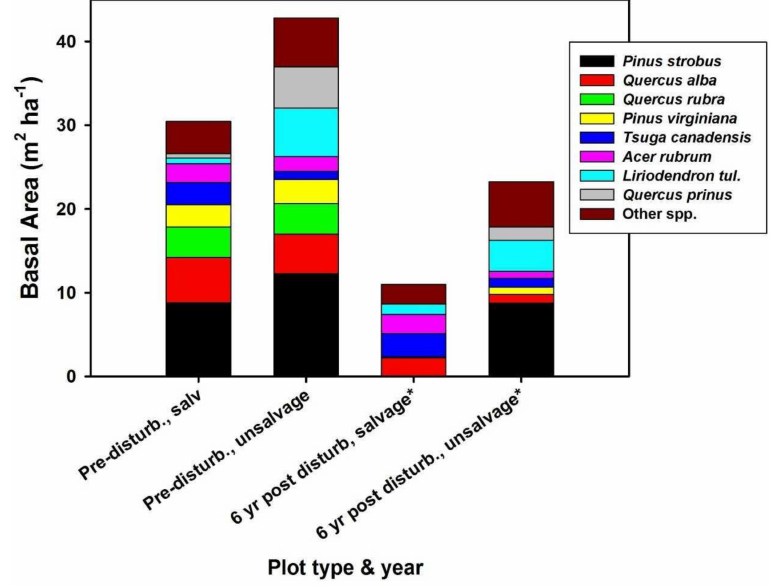
Figure 7. Stacked bars show the basal area (m 2 ha − 1 ) per species per disturbance condition: pre-tornado pre-salvage, pre-tornado unsalvaged, post-tornado post-salvage, and post-tornado unsalvaged. Saplings were included in the post-tornado (2017)